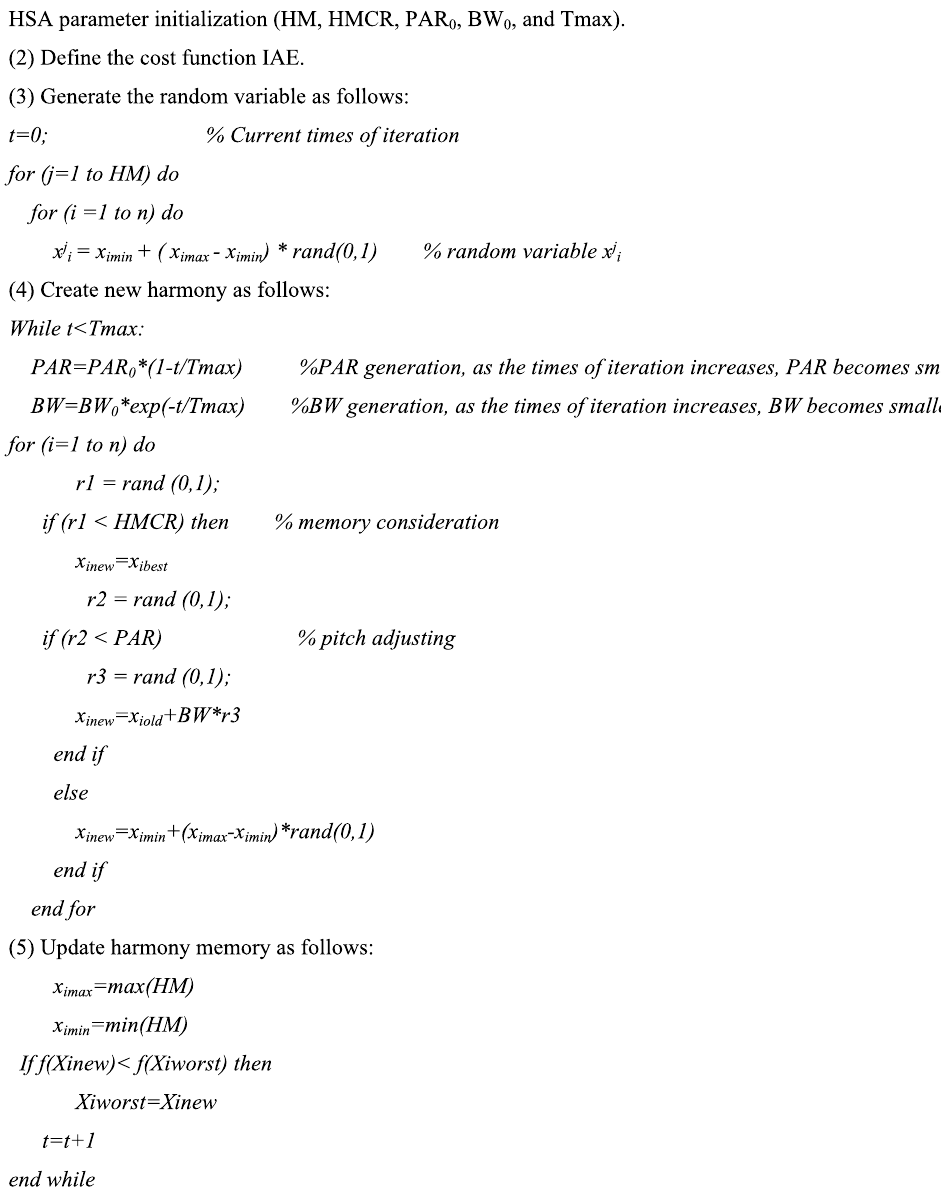
Lyapunov determination method. Lyapunov is a Russian mathematician who derived the famous sta- bility criteria for linear and nonlinear systems. Lyapunov theorem points out that if there is a unique P = P T > 0 satisfying Eq. (23) for any Q = Q T > 0 , then that system is asymptotically stable 42 .